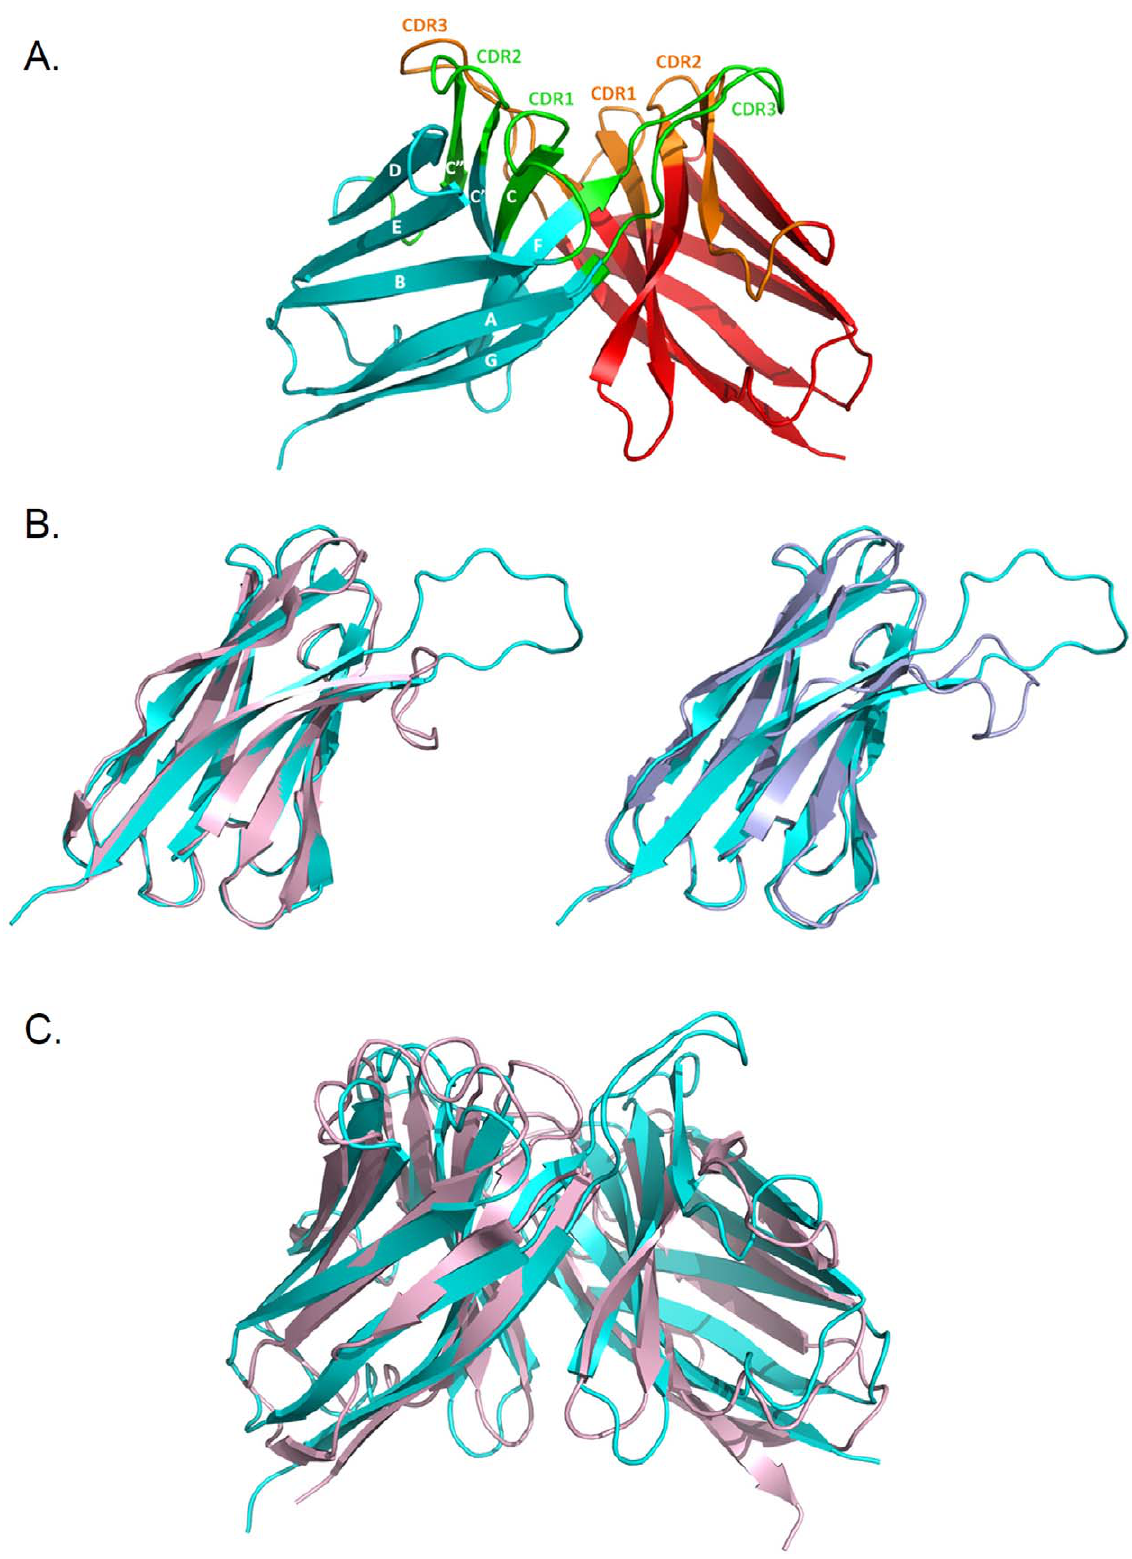
Figure 3. Structure of Gr6 and comparison of Gr6 with cV H -E2 and F v -POT. ( A ) Ribbon diagram of the Gr6 structure shown in cyan (chain A) and red (chain B). CDRs are colored in green in chain A and orange in chain B. The b -strands are labeled by following the Kabat nomenclature. ( B ) Ribbon diagramofthe superimposed F v -POT Heavychainontothe monomer of Gr6(left) andthesuperimposed cV H -E2monomer ontoGr6 monomer (right): cyan, Gr6; light pink, F v -POT heavy chain; light blue, cV H -E2. ( C ) Ribbon diagram of the superimposed F v -POT and Gr6 dimer: light pink, F v -POT; cyan, Gr6. doi:10.1371/journal.pone.0030149.g003 PLoS ONE | www.plosone.org 4 January 2012 | Volume 7 | Issue 1 |